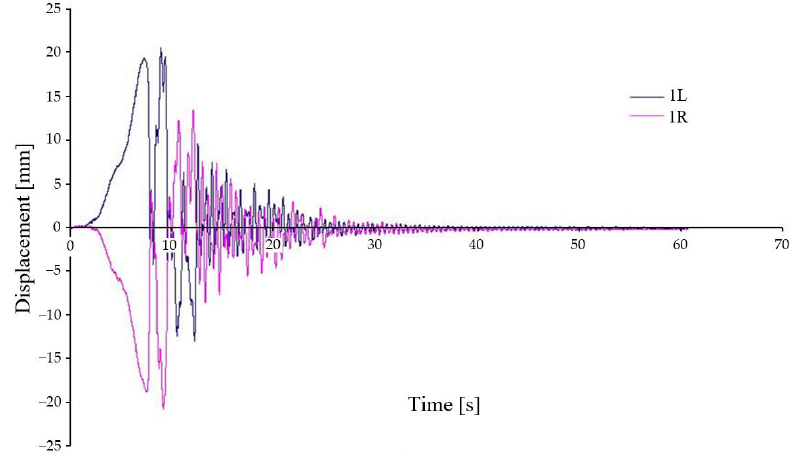
Figure 16. Relative displacement between chassis frame and wheelset—variant D-IV.